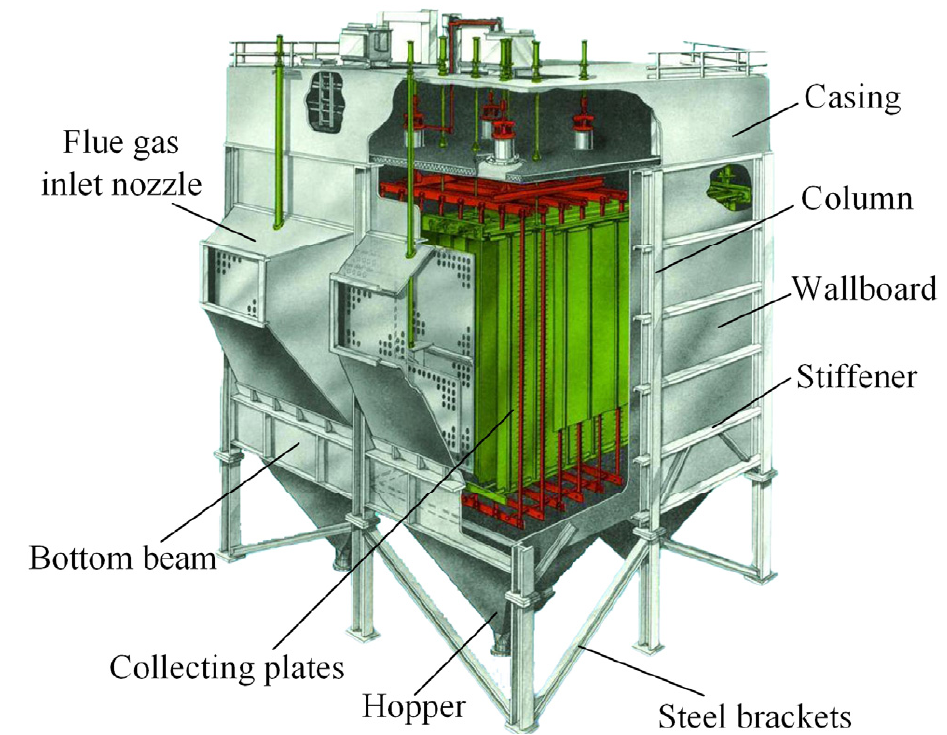
Figure 1. Overall structure diagram of an electrostatic precipitator.